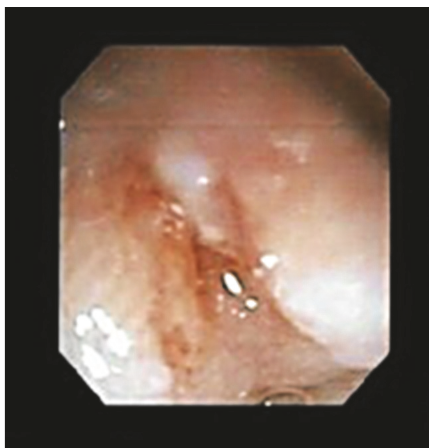
Figure 1: Duodenal ulcer in the duodenal bulb as seen on EGD.